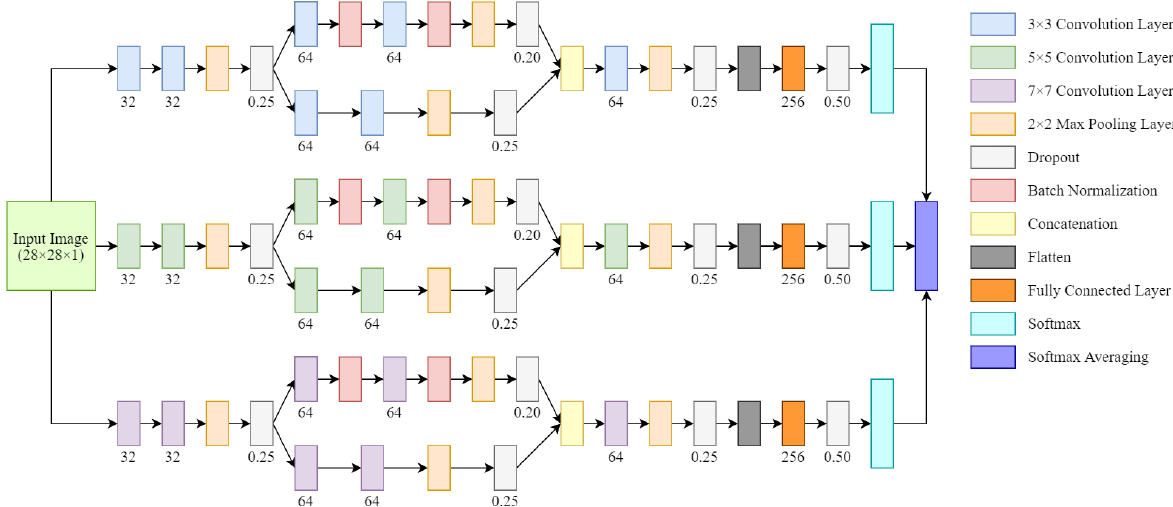
Figure 4. Proposed BengaliNet Architecture: A Low-Cost Novel Deep Convolutional Neural Network. Numbers below the layers indicate number of filters for convolutional layers, dropout values and number of neurons for fully connected